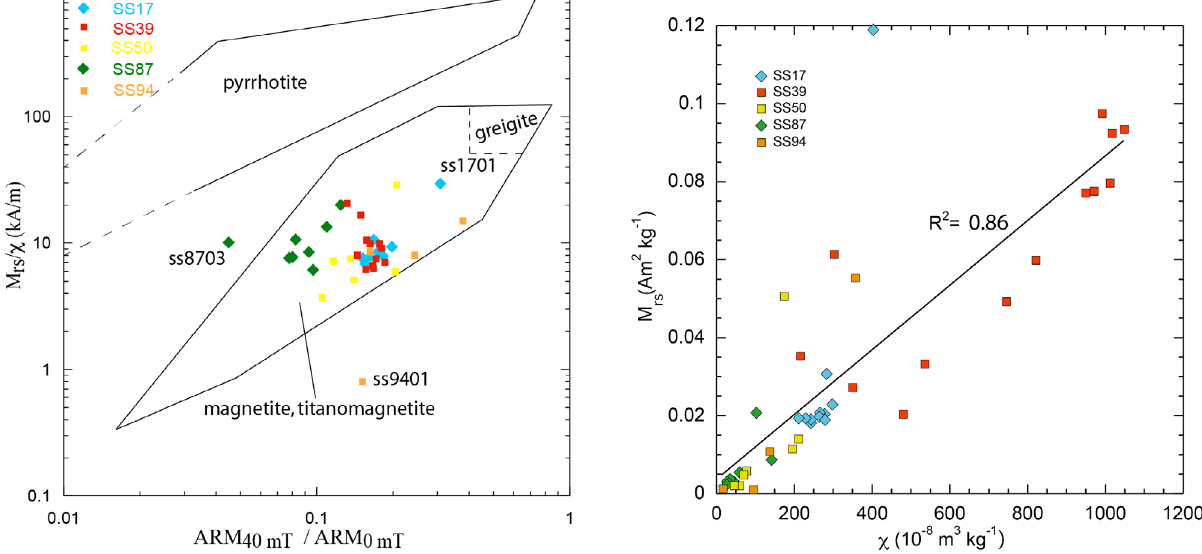
/ | versus ARM /ARM (where ARM is the magnetization remaining after demagnetization at 40 mT). Figure 6 (left). Biplot of M rs 40mT 0mT 40mT Black lines delimited the field of different magnetic phases (semi-empirical area redrawn from Peter and Thompson [1998]). versus | with indicated the linear regression curve. R 2 = correlation Figure 7 (right). Plot for soil samples of M rs